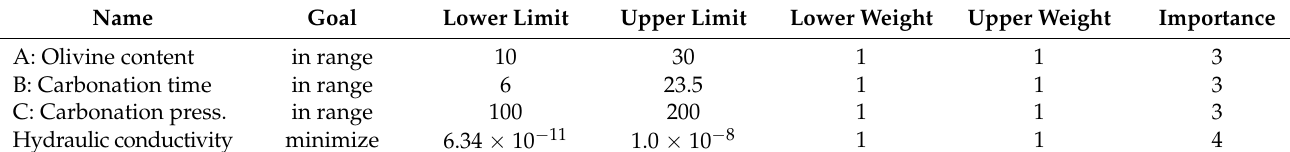
Table 6. Optimization of the individual responses (di) in order to obtain the overall desirability response (D).